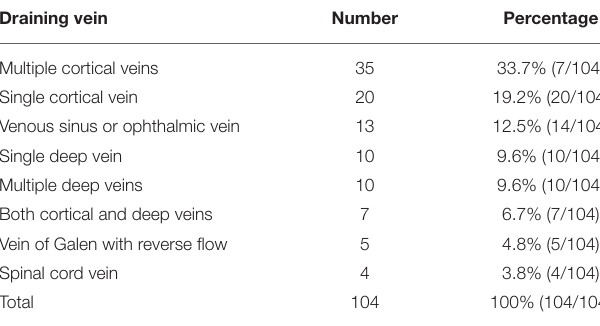
TABLE 3 | Venous drainage patterns of dural arteriovenous fistulas.